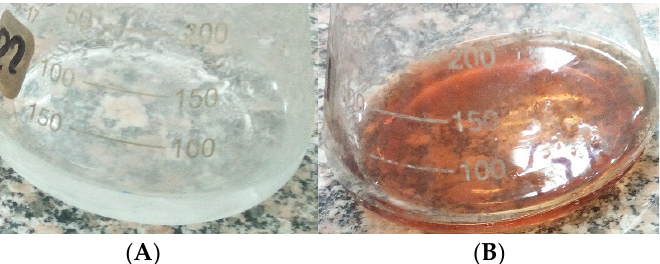
Figure 1. Biosynthesis of silver nanoparticles color change reaction in the present of extracellular filtrate of the Streptomyces aizuneusis ATCC 14921 biomass ( A ) and the presence of extracellular filtrate of the Streptomyces aizuneusis biomass exposure to AgNO 3 solution after 7 days ( B